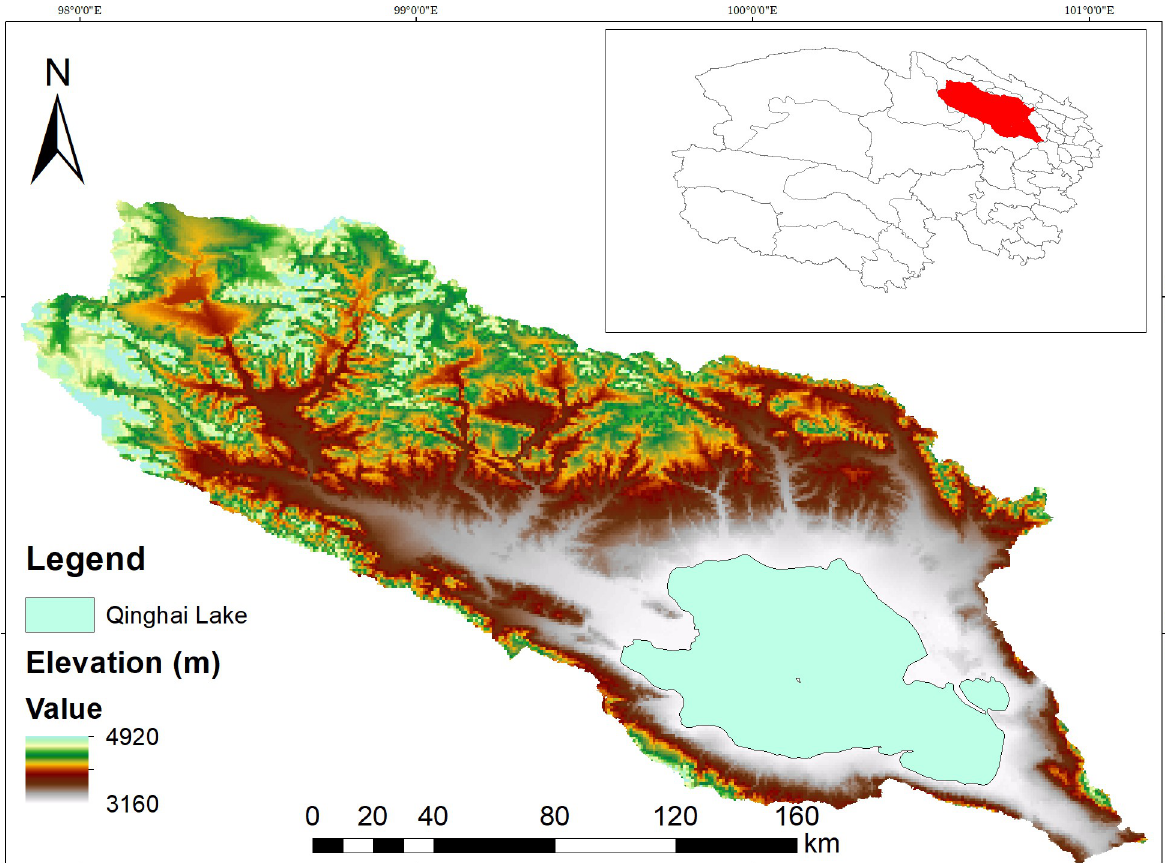
Fig 1. Area of Interest (AOI): Qinghai Lake basin in Qinghai province, People’s Republic of China. ArcGIS was used to process the raster obtained from WorldClim (http://worldclim.org/version2) to draw AOI map, with kind permission of Dr. Stephen Fick, geo-spatial data scientist. The boundary lines should not be reused or misinterpreted for any political